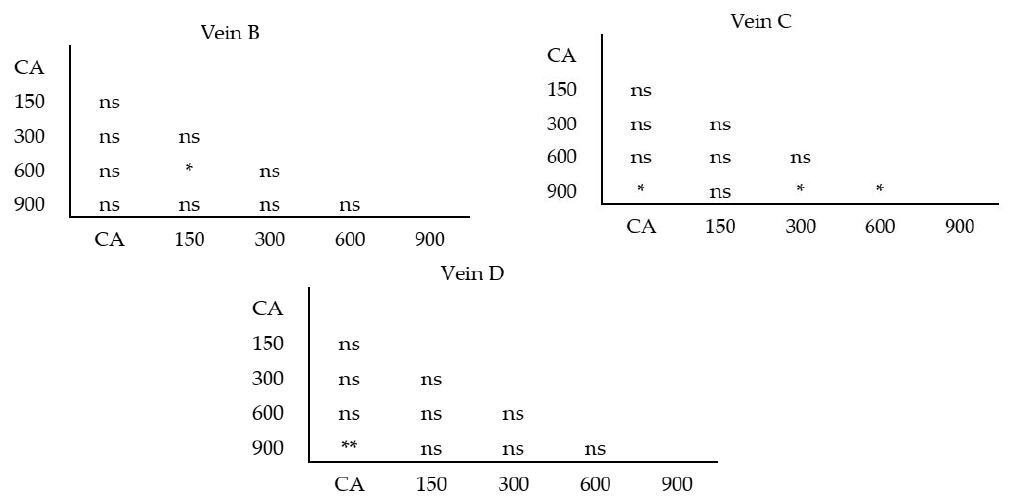
Figure 10. Student t- test between studied doses of neomycin (150–900 mg / L) and control group (CA) for three studied veins; * p < 0.05, ** p < 0.01, ns— p > 0.05.